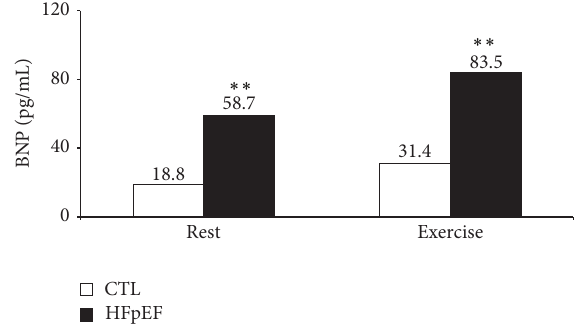
Figure 2: Changes in brain natriuretic peptide at rest and at peak exercise in patients with HFpEF versus healthy subjects. BNP: brain natriuretic peptide. Values are expressed as adjusted geometric mean. Significantly different from HFpEF values: ∗∗ 𝑃 < 0.01